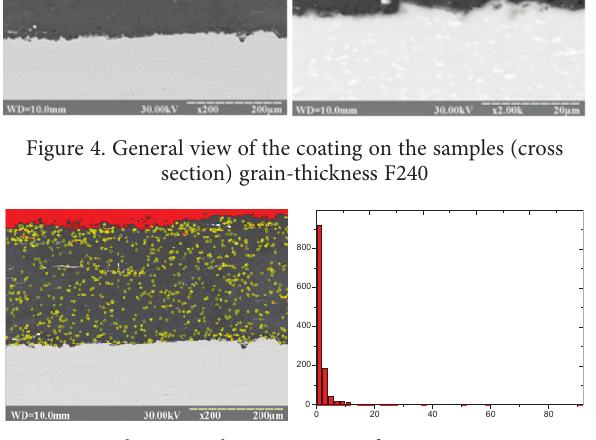
Figure 5. Selection and measurement of pore area in coating, grain-thickness F240 Table 2. Al 2 O 3 coating